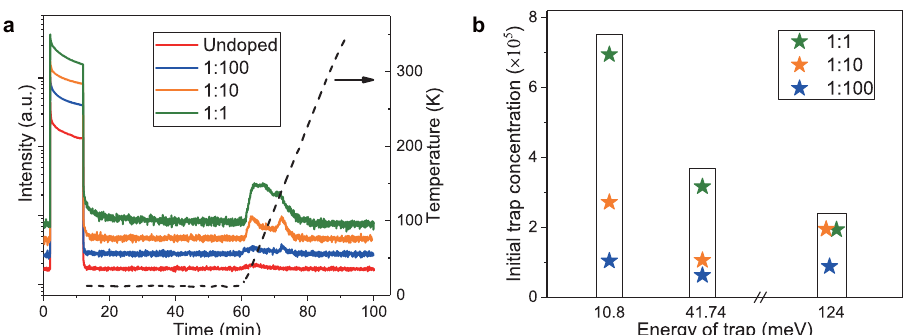
Fig. 3 Thermoluminescence and energy traps. a X-ray thermoluminescence plots of undoped, 1:100, 1:10, and 1:1 Li-(PEA) 2 PbBr 4 . The dashed line indicates the rise of temperature. b Initial trap concentration at corresponding energy from 1:100, 1:10, and 1:1 Li-(PEA) 2 PbBr 4 . For clarity, the symbols of 1:10 and 1:1 are intentionally separated due to their